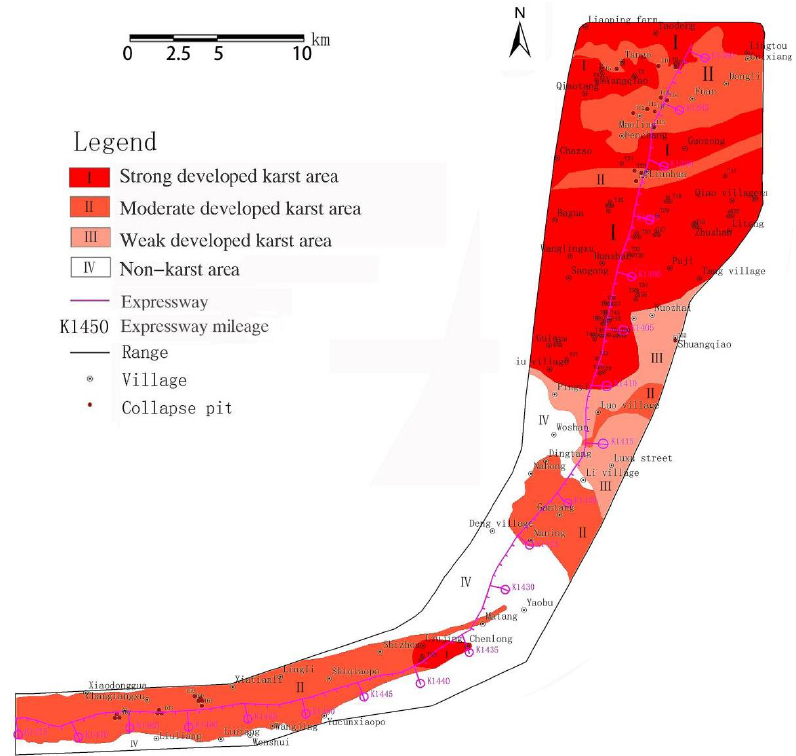
Figure 8. Zoning map of influence degree of karst development on karst collapse.